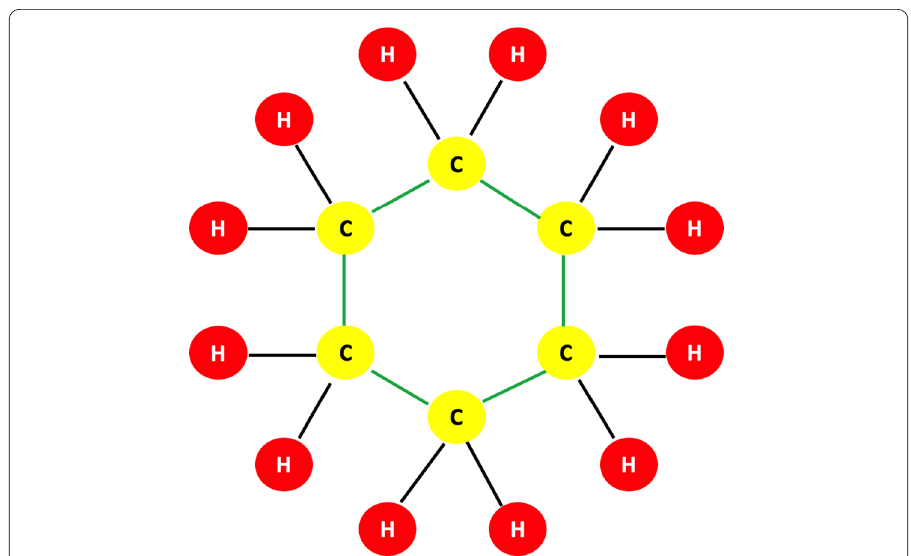
Figure 2 Chemical bond of cyclohexane compound